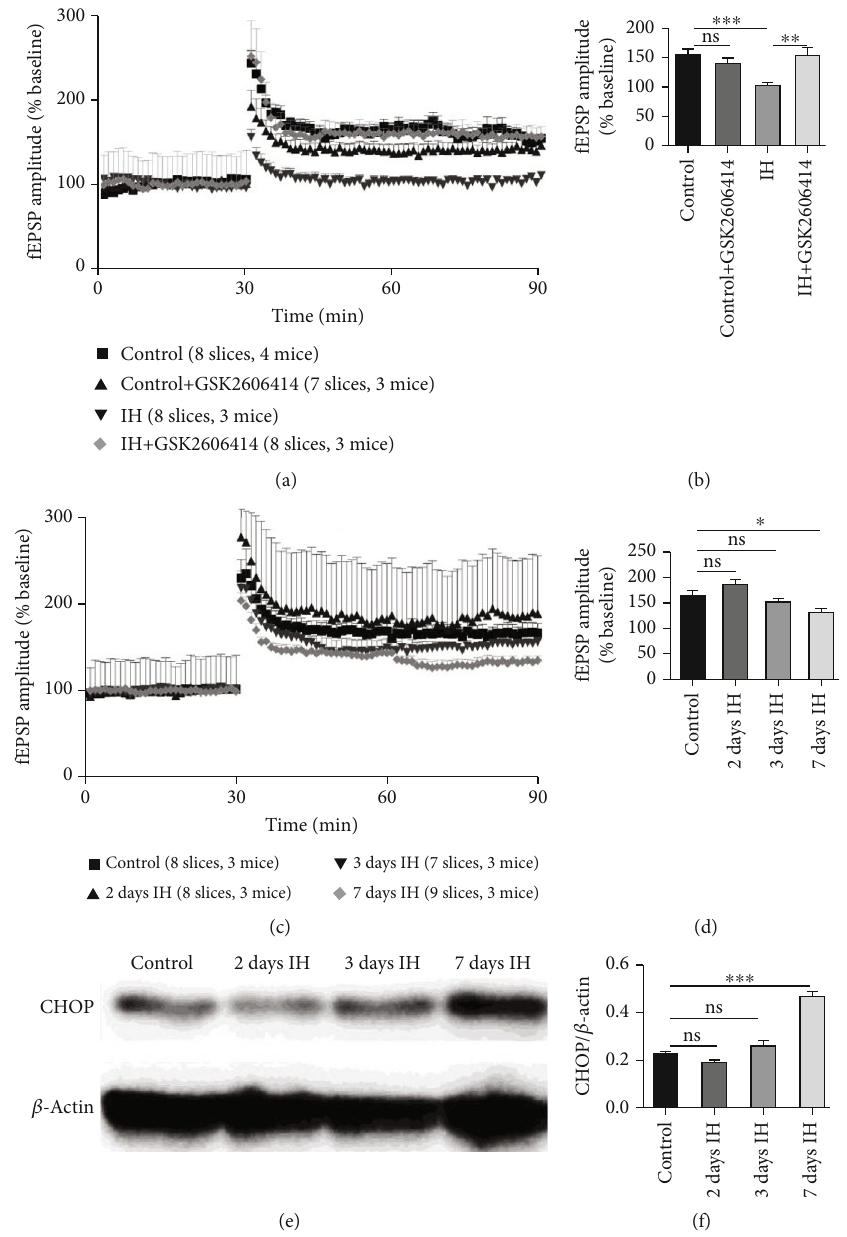
Figure 5: The impairment of hippocampal synaptic plasticity was induced by chronic IH treatment (7 and 14 days) which was associated with the increased expression of CHOP. GSK2606414 could rescue this impairment. (a) GSK2606414 prevented chronic IH-induced impairment in hippocampal LTP. (b) Quanti fi cation of the results shown in A. (c) hippocampal synaptic plasticity was not impaired after 2 or 3 days of IH treatment. (d) Quanti fi cation of the results shown in C. (e) Representative western blots showed that the expression of CHOP was not increased in hippocampal tissue after 2 or 3 days of IH exposure. The pooled data from three mice for each group are summarized in (f). ∗ P < 0 : 05 ; ∗∗ P < 0 : 01 ; ∗∗∗ P < 0 : 001 ; ns: not signi fi